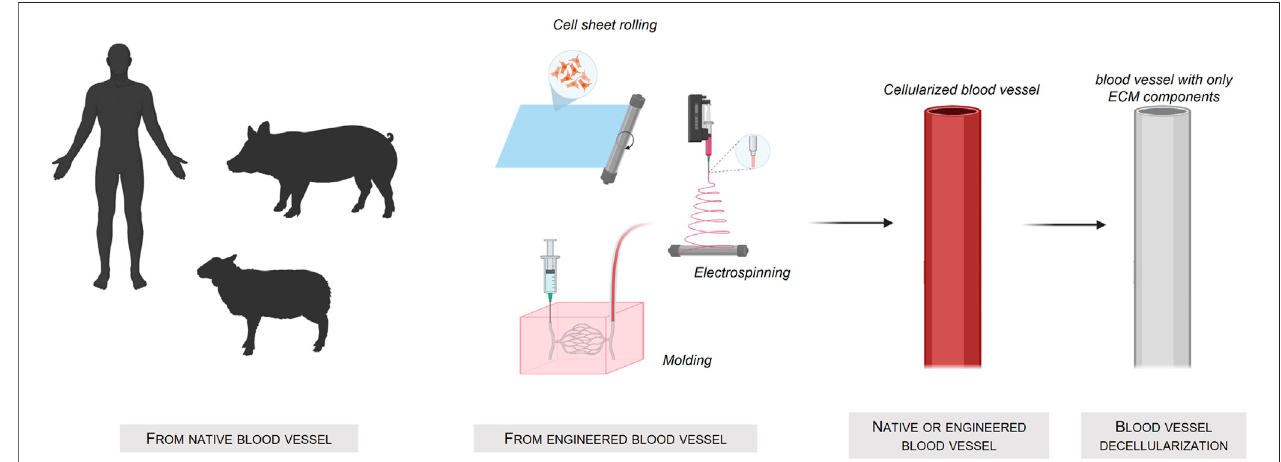
FIGURE 3 | Fabrication of tissue-engineered blood-vessel using a native or engineered blood vessel source.